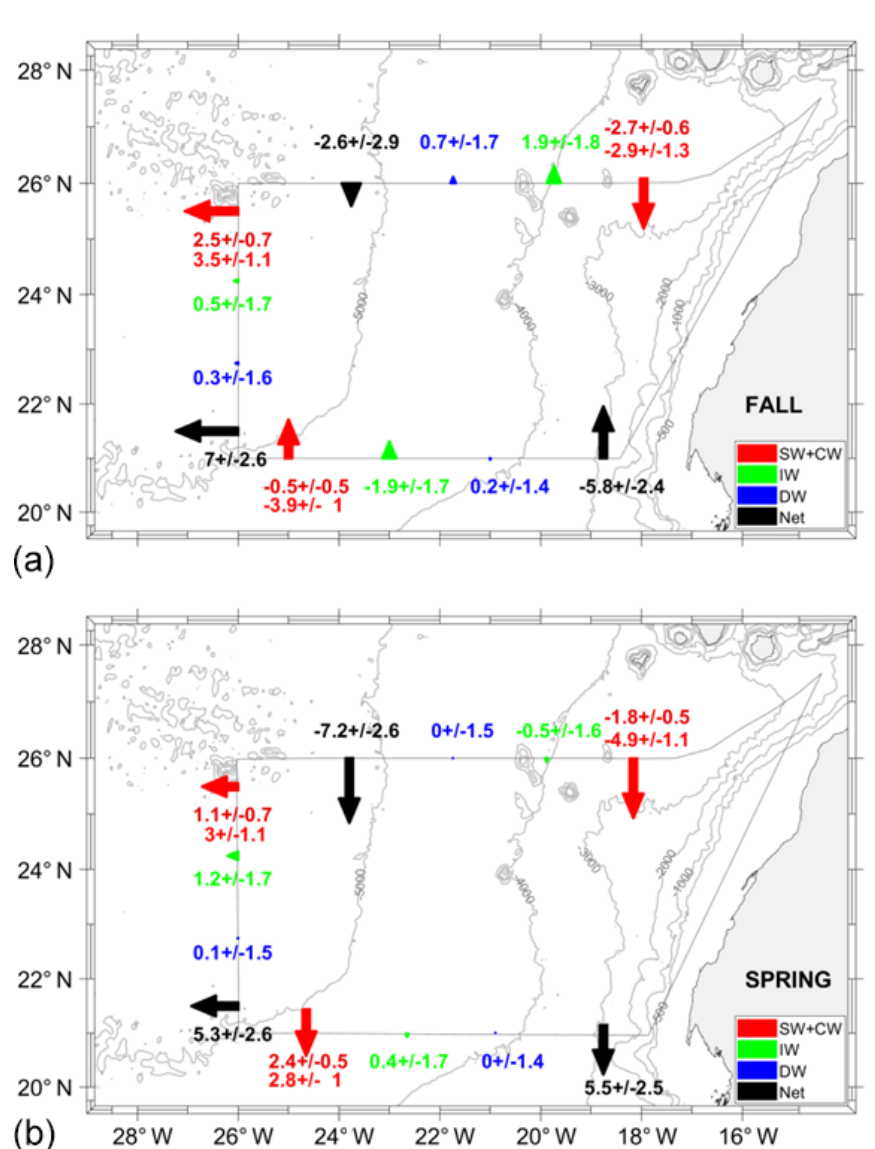
Figure 14. Mass transports with their errors (Sv) at the surface and central waters (SW + CW, red arrow), intermediate waters (IW, green arrow), and deep waters (DW, blue arrow) across every transect during fall (s) and spring (b) . Negative–positive values indicate inward– outward transports as in Fig. 12. The arrows in each transect are located at positions that optimize their visibility, representing the integrated transports along each transect. The values of transports at SW (dark red) are given next to the integrated values of transports at CW levels (in